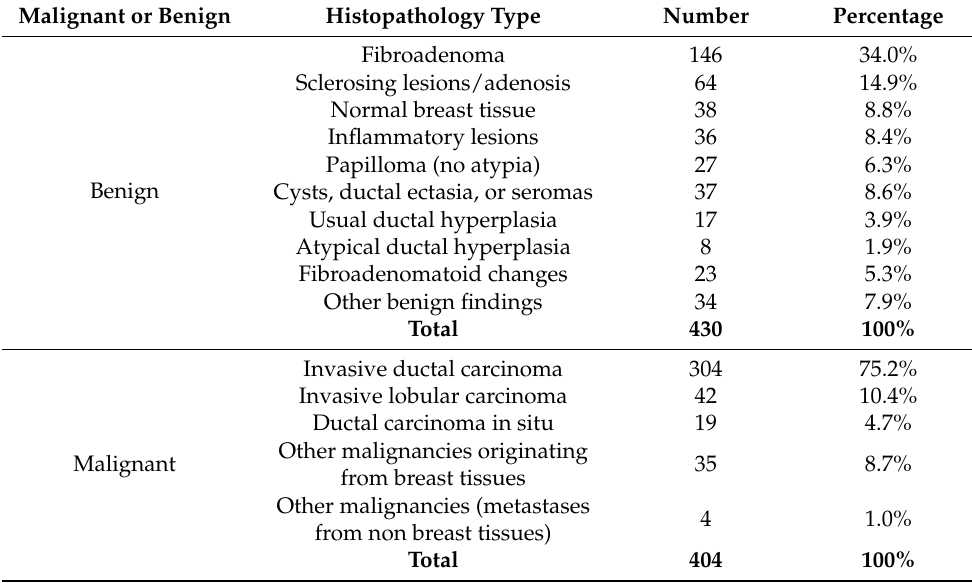
Table 1. Histopathology of the 834 breast masses included in the